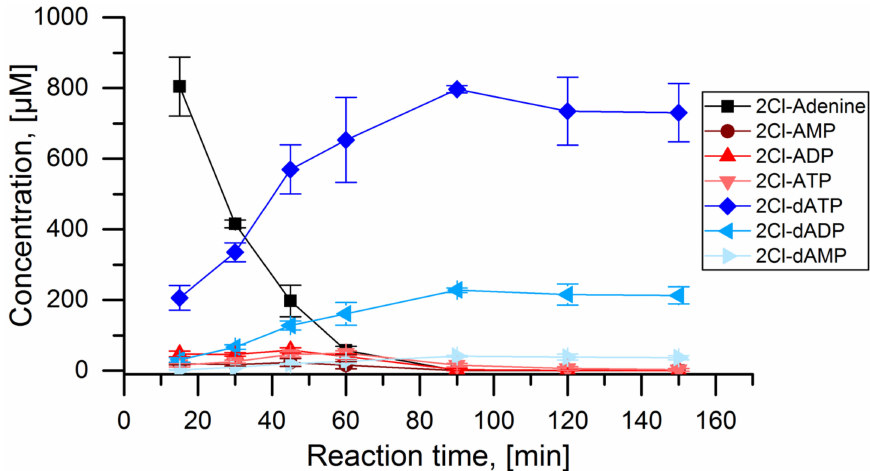
Figure 5. APT-PPK-RNR reaction cascade with 2Cl-adenine as substrate: Concentrations of 2Cl- adenine and all detected 2Cl-adenosine nucleotides over the time course of the full cascade reaction with 1 mmol L − 1 2Cl-adenine as initial substrate. Applied enzyme concentration: APT: 1 µ mol L − 1 , PPK: 400 nmol L − 1 , RNR: 5 µ mol L − 1